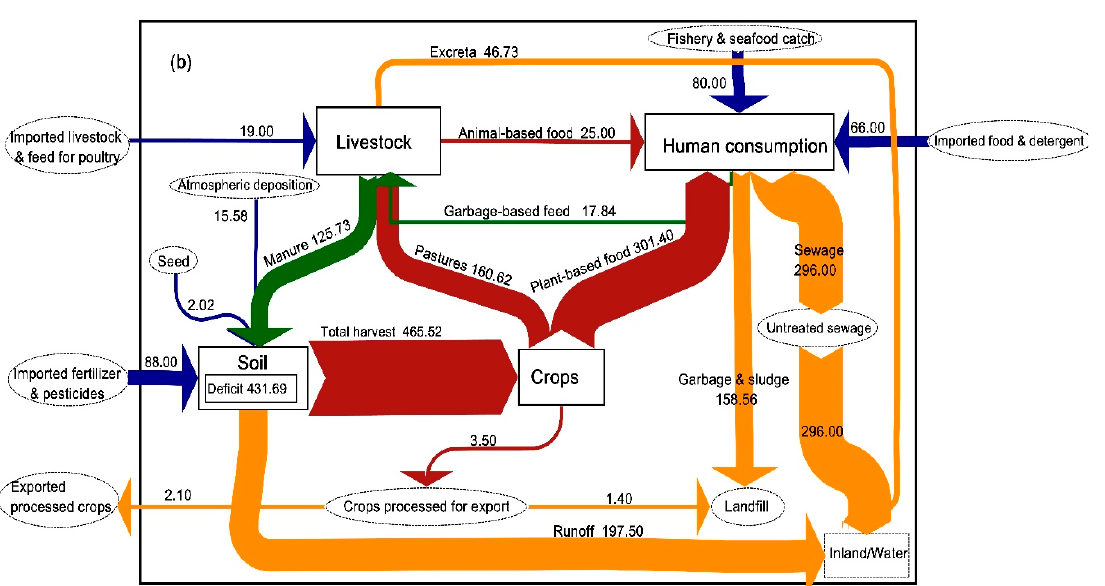
Figure 3. P flows through the food production and consumption system of Comoros in ( a ) 2000 and ( b ) 2011 (unit: t P). Arrows are sized relative to the magnitude of the flow, with a size of four as the lower flow threshold for small streams. Orange arrows are P output flows, blue arrows, P input flows, green arrows, recycling P flows internal to the system, and red arrows, P internal flows between subsystems. The large black-outlined boxes show the physical boundary of the